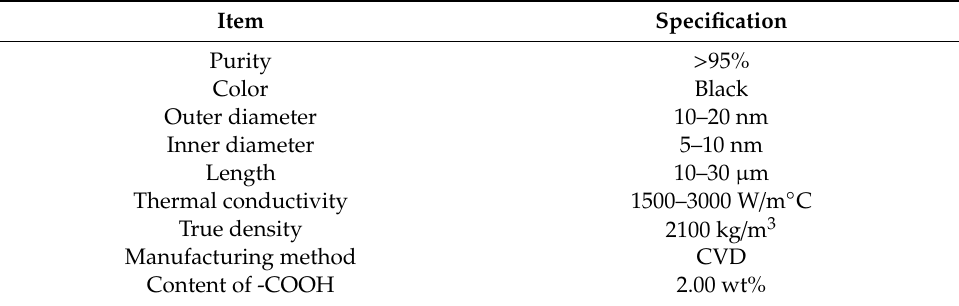
Table 2. Physical properties of MWCNT nanoparticles